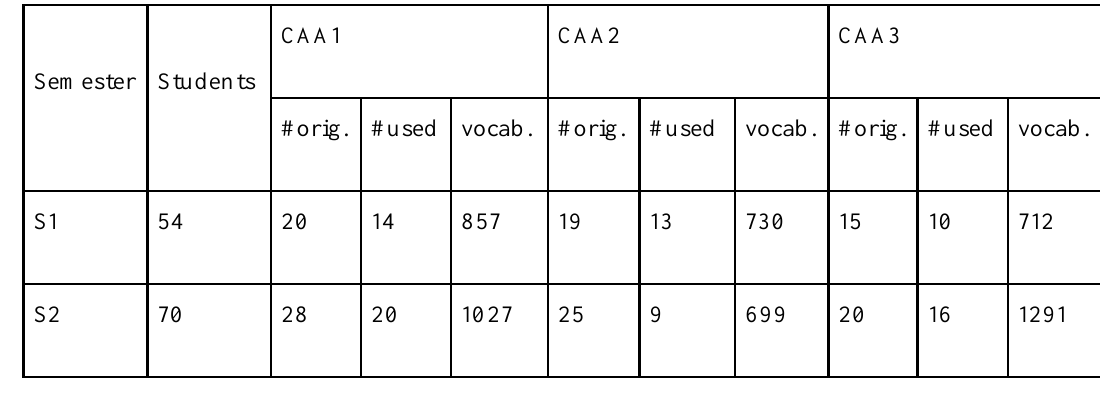
Registered Students, Number of Original CAAs (#orig.), Number of Used CAAs (#used), and Vocabulary Size Used (vocab.) for each Semester